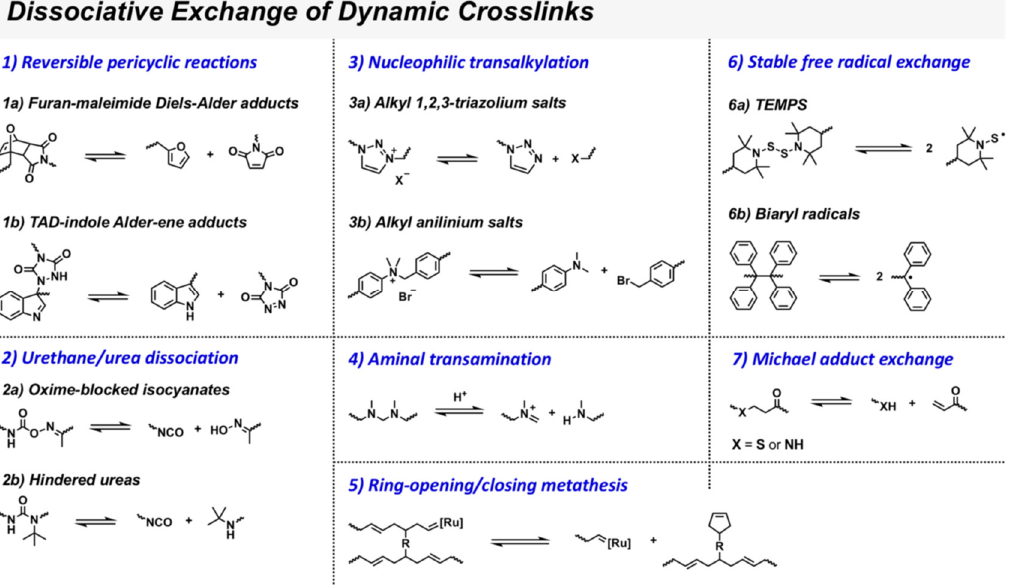
Figure 3. Review of crosslink chemistry used for dissociative covalent adaptive networks (TAD, triazolinedione; TEMPS, tetramethylpiperidine-1-sulfanyl). Reprinted with permission from [68]. Copyright (2019) American Chemical Society.